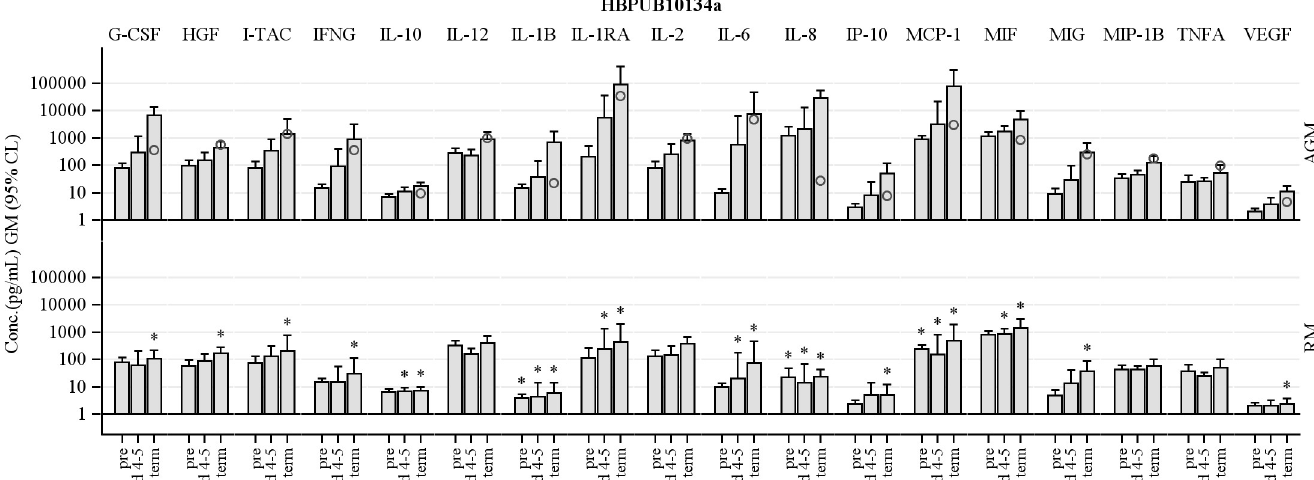
Fig 5. Comparison of serum cytokine and chemokine levels in AGMs and RMs aerosolized with B . pseudomallei HBPUB10134a. Levels of G-CSF, HGF, I-TAC, IFNG, IL-10, IL-1 β , IL-1RA, IL-6, IL-8, IP-10, MCP-1, MIF, MIG and VEGF were measured in sera at baseline, days 4–5 post exposure, and at the terminal bleed. � indicates a statistically significant difference between AGMs and RMs within time point ( p < 0.05). Plotted values indicate the geometric mean (GM) concentration, with error bars extending to the 95% CL. The terminal time point includes both animals that succumbed, and those that were euthanized at the end of the study. All AGM succumbed to the challenge, while only one RM succumbed. To illustrate the potential effect of succumbing, an open circle is plotted along with the terminal time point of AGM to indicate the concentration of the specific cytokine or chemokine in the moribund